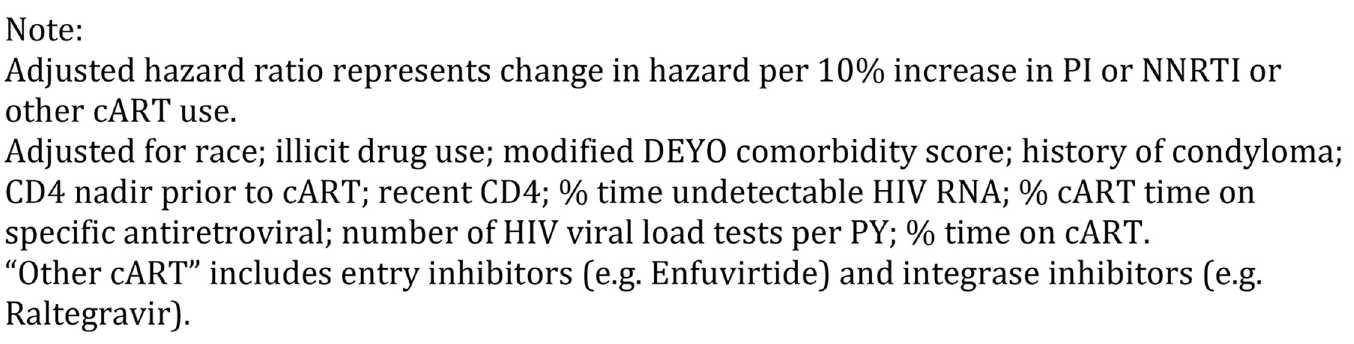
Fig 2. Box and Whisker Plot Showing Squamous Cell Cancer of the Anus Risk Associated with Protease Inhibitor, Non-Nucleoside Reverse Transcriptase Inhibitor, and Other CART